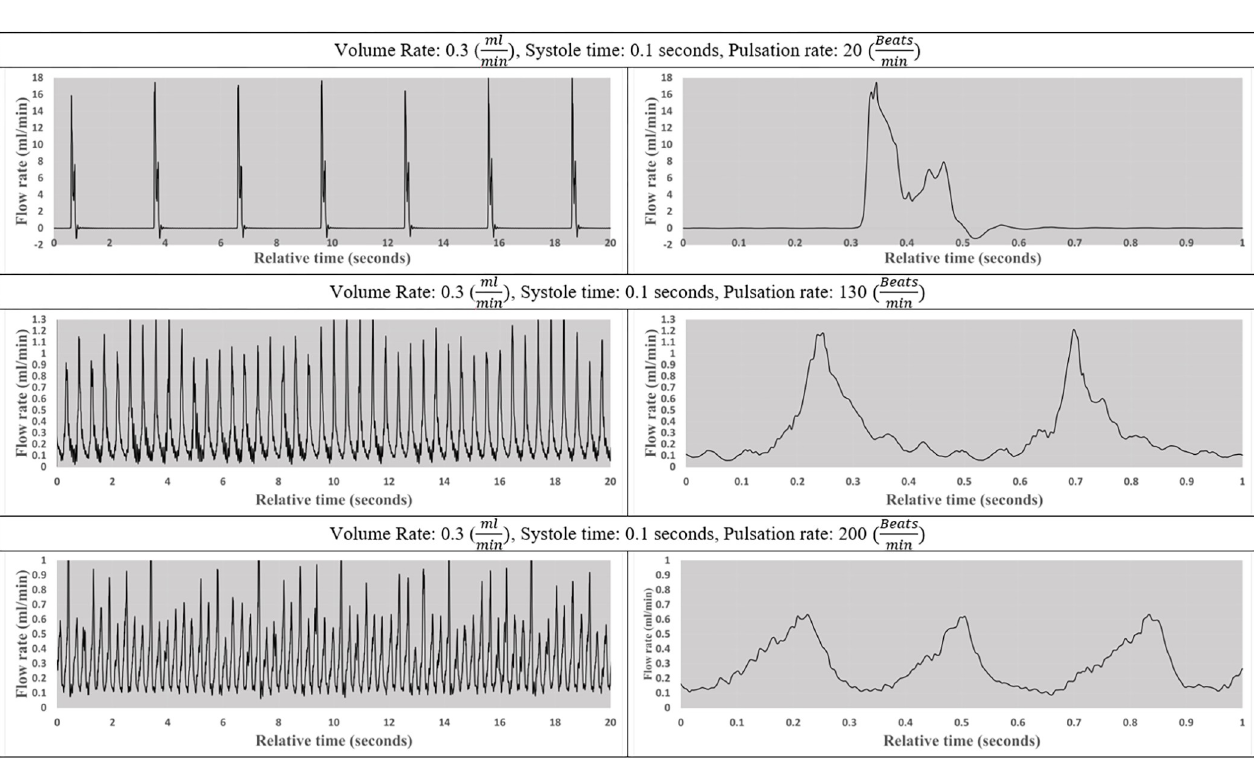
Fig 5. The impact of pulsation rate on flow pattern. Visual representation of flow pattern at 20, 130, and 200 beats